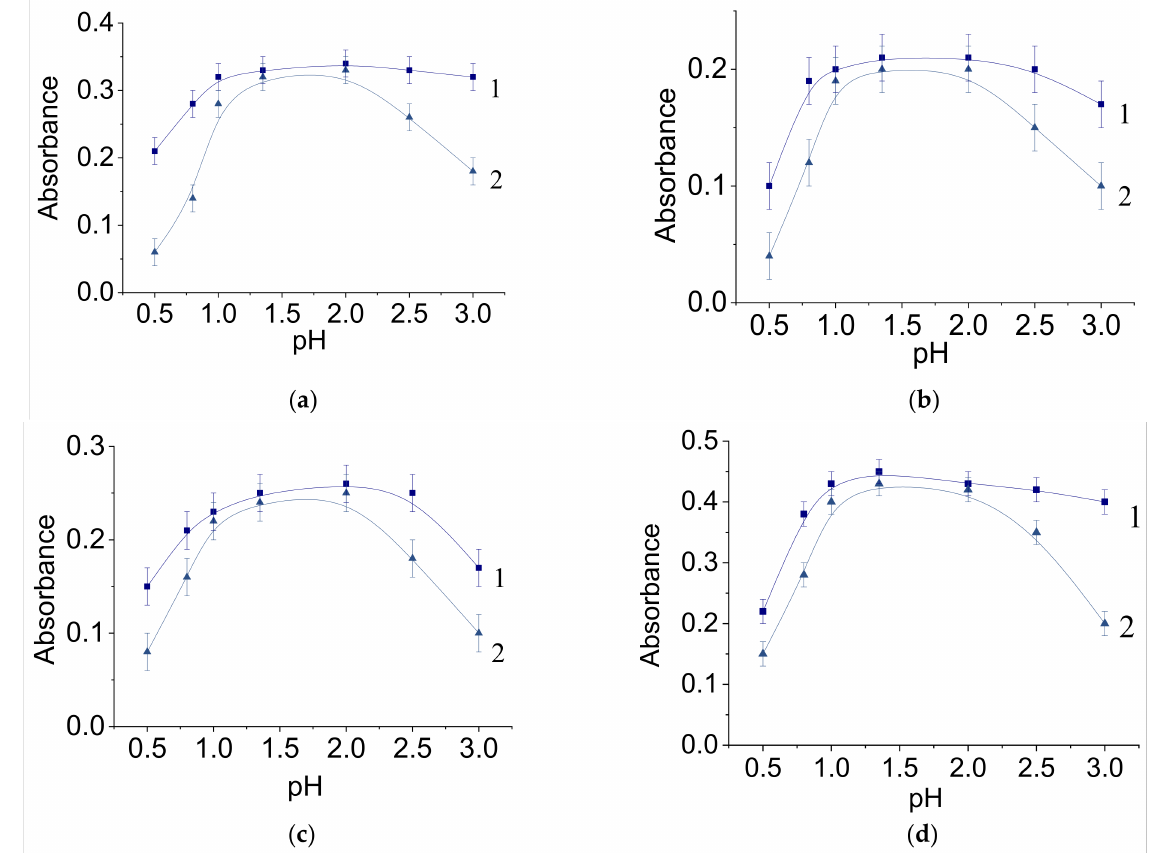
Figure 7. The dependence of the absorbance on the pH of the dispersion medium for dispersions of molybdenum–tungsten blue of various compositions: (Mo)/(W) = 95/5 ( a ), (Mo)/(W) = 90/10 ( b ), (Mo)/(W) = 80/20 ( c ), and (Mo)/(W) = 50/50 ( d ). The measurements were carried out 1 (curve 1) and 7 (curve 2) days after preparation of the samples.